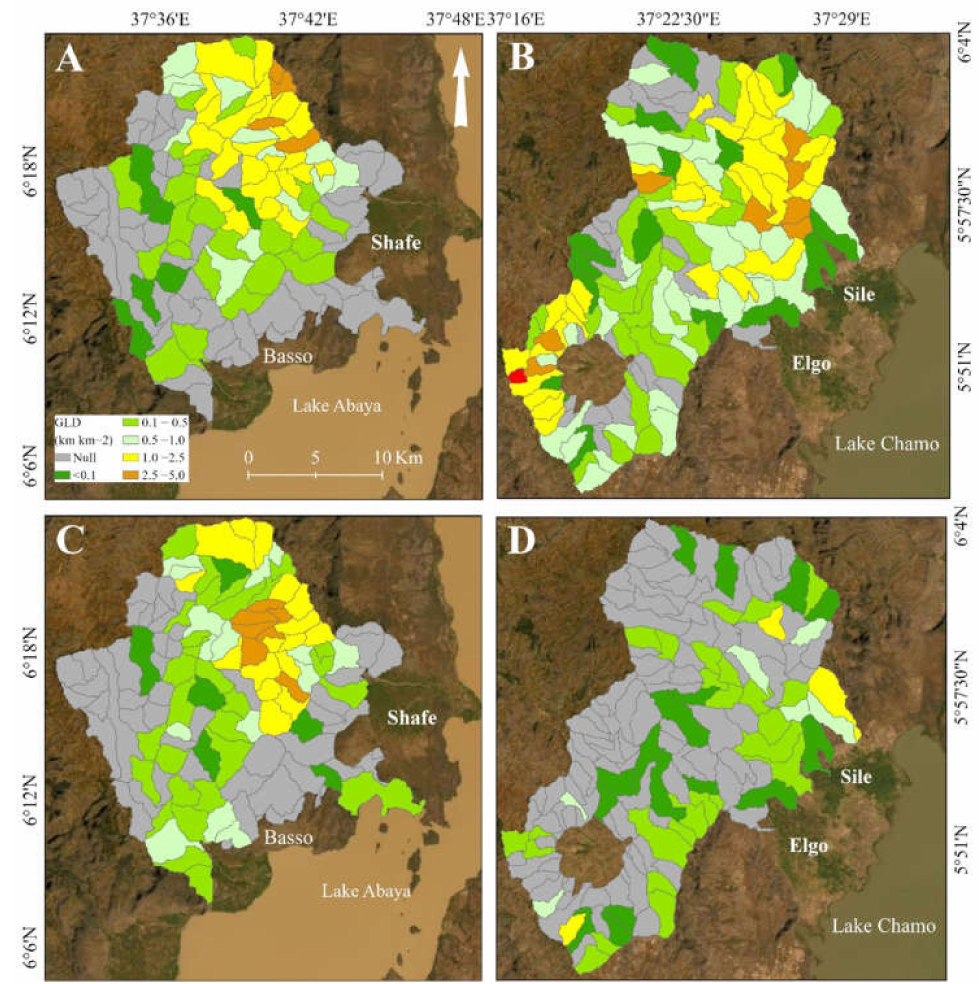
Figure A2. The GLD, for partially active ( A , B ) and inactive ( C , D ) gullies of each river catchment. The densities are represented at the level of the sub-catchments. Background imagery is from Google Earth (15 June